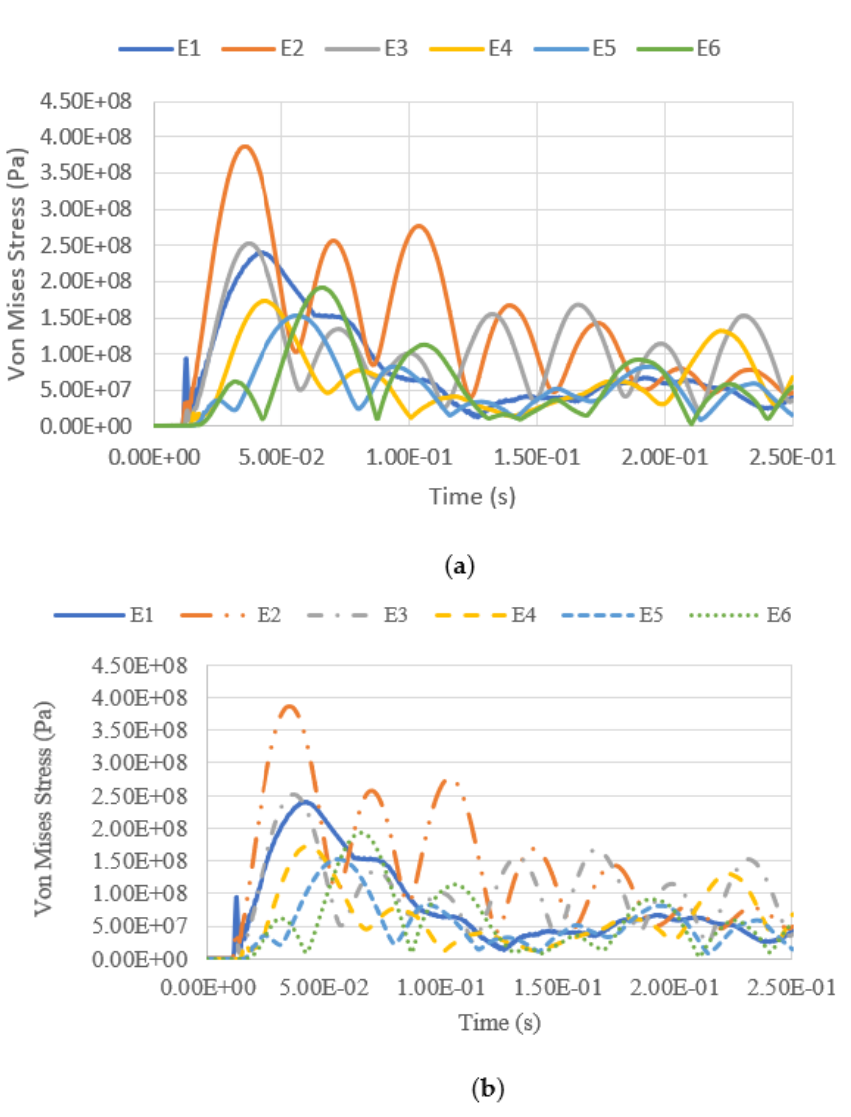
Figure 21. Equivalent stress versus time under blast intensity of 380 kg TNT equivalent mass 12.5 m away, ( a ) 100% fill and ( b ) 0% fill.